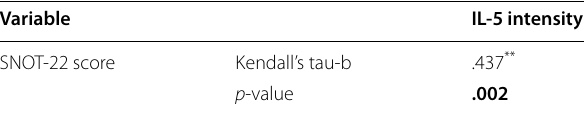
Table 5 Correlation between IL-5 intensity and SNOT-22 score